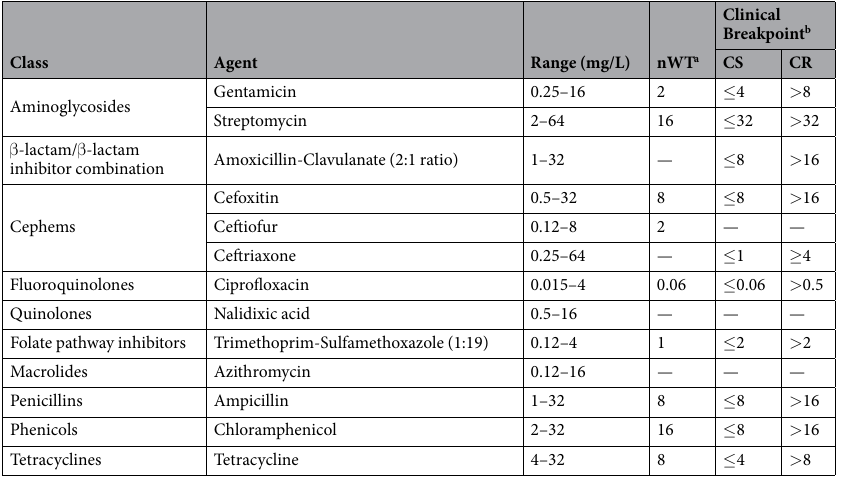
Table 1. Breakpoints used for susceptibility testing of Salmonella species. a nWT = non-wild type [EUCAST epidemiological cut-off values (mg/L) (ECOFF)]. b CLSI VETO1S,(CLSI, 2015) or M100S(CLSI, 2016) breakpoints (mg/L), CS = Clinically-sensitive; CI = Clinically-Intermediate (between CS and CR, not shown); CR = Clinically-resistant. “—” Not defined.